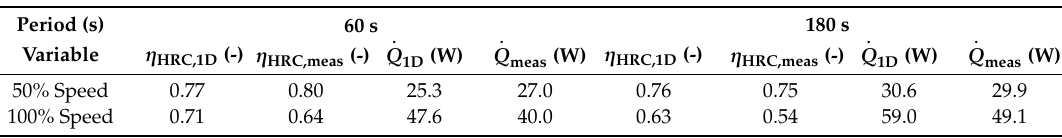
Table 7. Average supply heat transfer rate and heat recovery e ffi ciency using the 1D model and measured